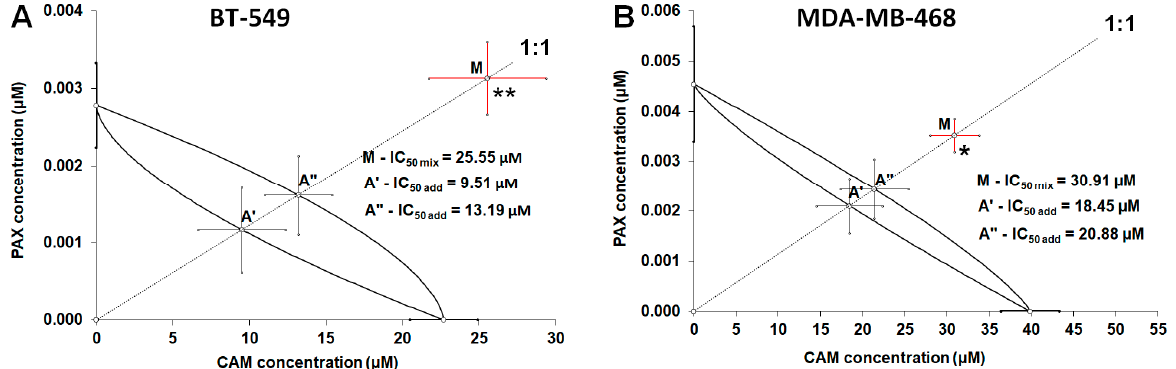
Figure 5. Isobolographic analysis of interactions between PAX and CAM in ( A ) BT ‐ 549 and ( B ) MDA ‐ MB ‐ 468 TNBC lines measured in vitro by the MTT assay. The IC 50 values for PAX and CAM are plotted on the ordinate and abscissa, respectively. The lower and upper isoboles of additivity represent the curves connecting the IC 50 values for PAX and CAM. The points A ′ and A ″ depict the theoretically calculated IC 50 add values, whereas the point M represents the experimentally ‐ derived IC 50 mix value. * p < 0.05 and ** p < 0.01 vs. the respective IC 50 add values (Student’s t ‐ test with Welch correction).